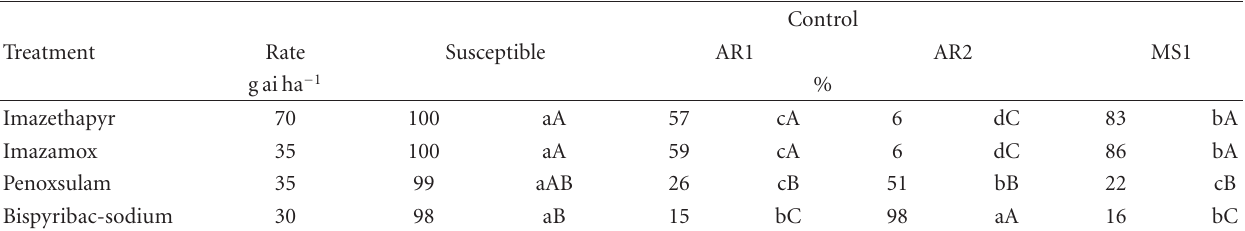
a Means for each population within a column followed by the same uppercase letters and means for each herbicide within a row followed by the same lowercase letters are not significantly di ff erent according to Fisher’s protected LSD test ( α = 0 . 05).